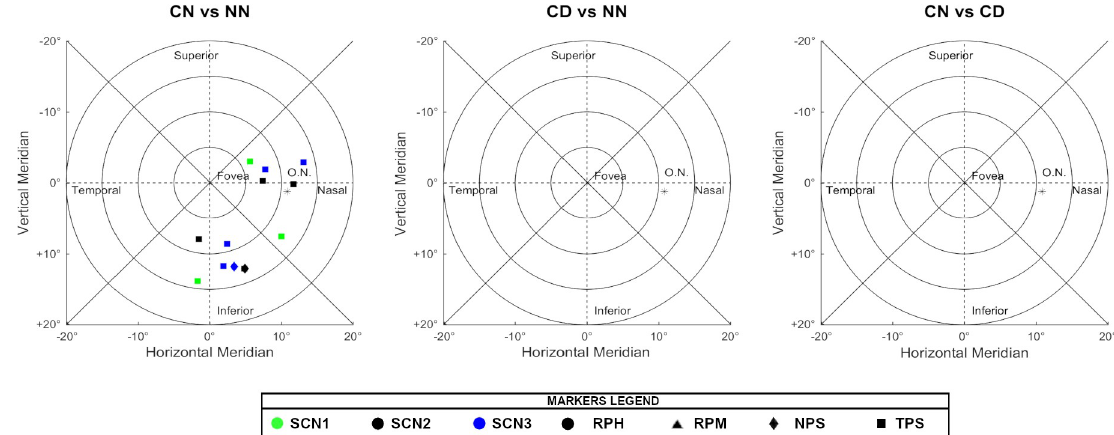
Fig 5. Non-significant differences in the post-hoc analysis when comparing the different optical treatments. The absence of markers indicates that those regions were significantly different under all conditions tested.